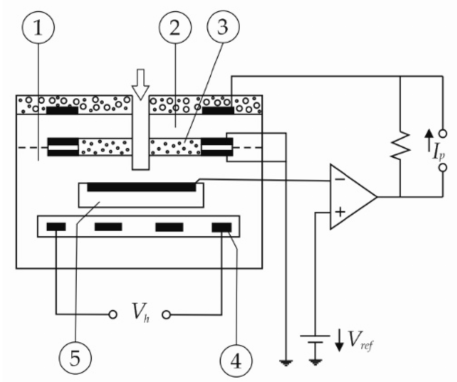
Figure 1. Schematic diagram of a wideband universal exhaust gas oxygen (UEGO) sensor: ( 1 ) sensor cell; ( 2 ) pump cell; ( 3 ) di ff usion barrier; ( 4 ) heater; ( 5 ) reference air.